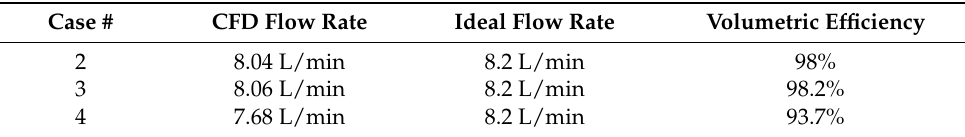
Table 8. Delivered flow rate and volumetric efficiency of the pump for three different fluids: mineral oil, Total BIOHYDRAN TMP 46, and olive